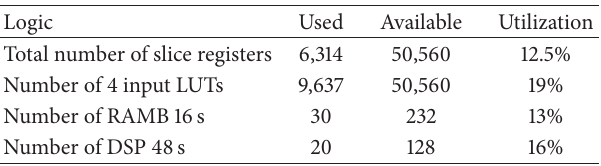
Table2:FPGAlogicutilizedbytheprofileshapematchinghardware design capable of processing images as large as the Teddy and